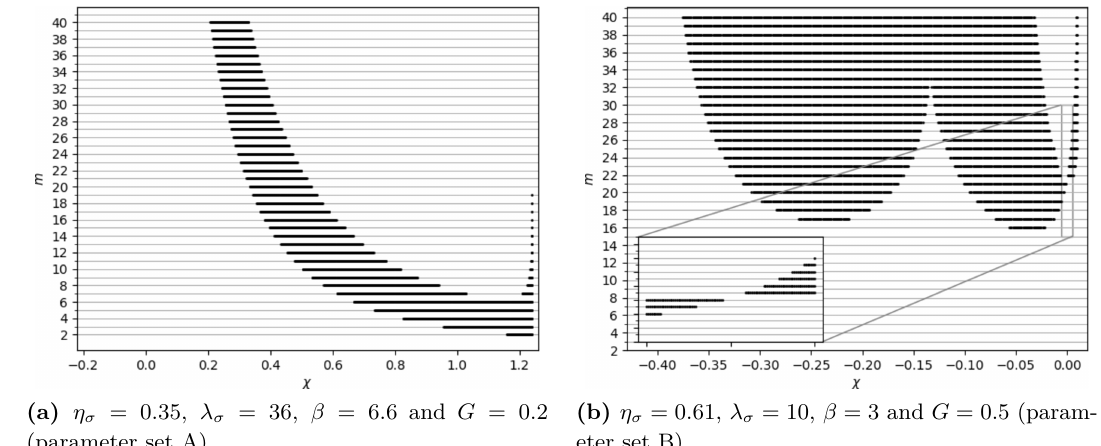
Figure 7 . The black regions show the range of χ for which vortons are expected to be unstable for modes between m = 2 and m = 40 . Only the regions χ > 1 . 02 (left) and χ > − 0 . 042 (right) are rele- vant due to the critical phase frequency. The right-hand figure indicates that vortons which are close to chiral are the most likely to be stable to all modes. The bottom left corner displays a zoomed in image of the region − 5 × 10 − 3 ≤ χ ≤ 5 × 10 − 3 for modes 15 ≤ m ≤ 30 and demonstrates that there is a region (approximately − 4 × 10 − 4 < χ < 8 × 10 − 4 ) which is predicted to be completely